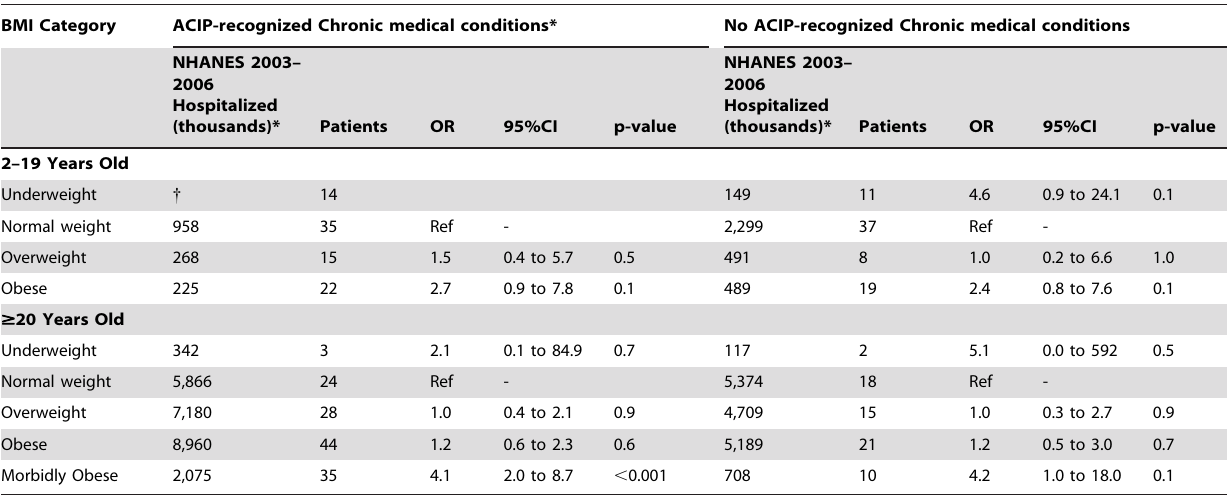
Table 3. Odds Ratio of BMI category for patients hospitalized with 2009 pandemic influenza A(H1N1) compared to the U.S.